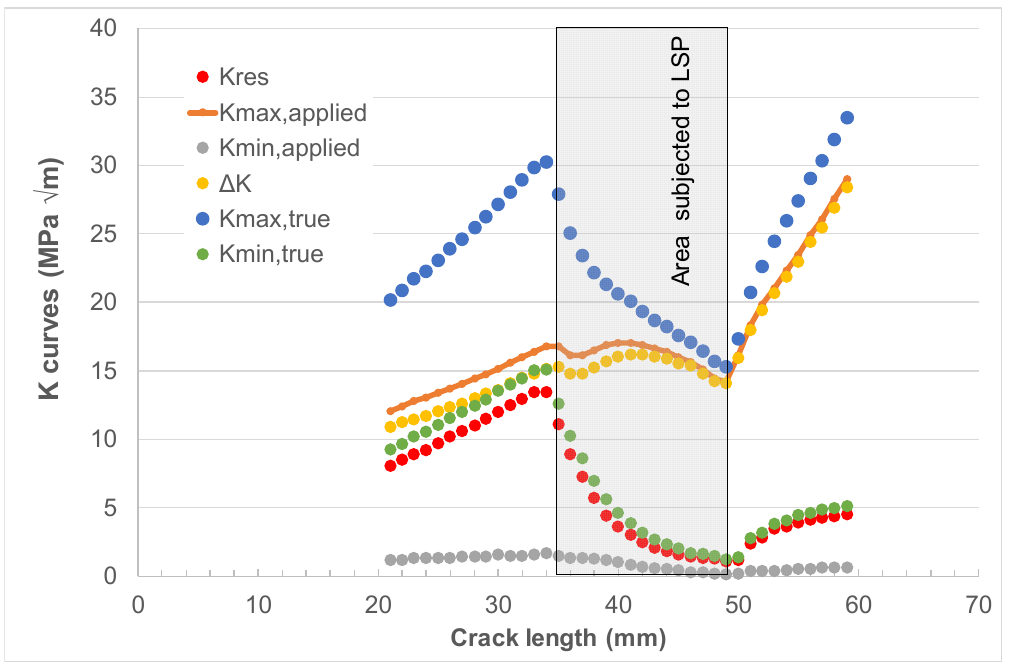
Figure 6. The various stress intensity factor versus crack length curves given in [75].